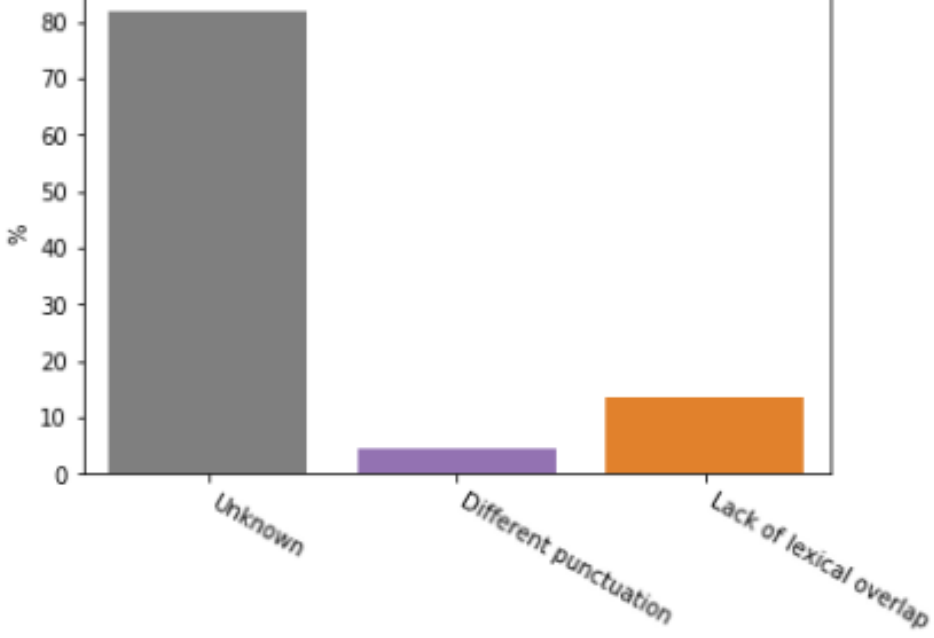
Figure 3. Common categories of error for cases when the model under-predicts similarity as identified by manual analysis of the 100 worst